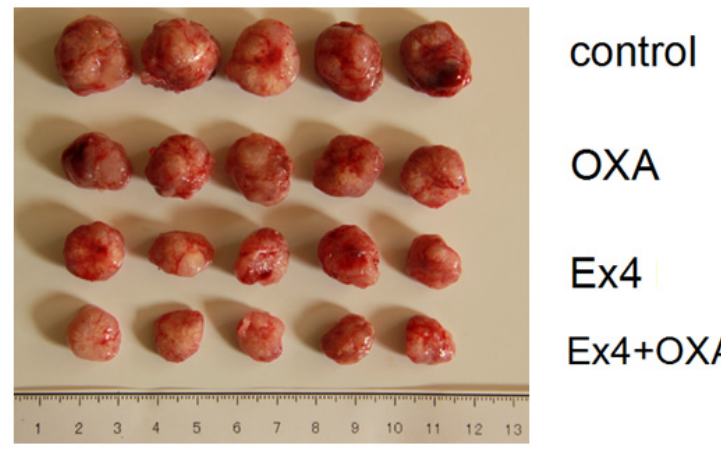
Figure 8. Tumor volume in different